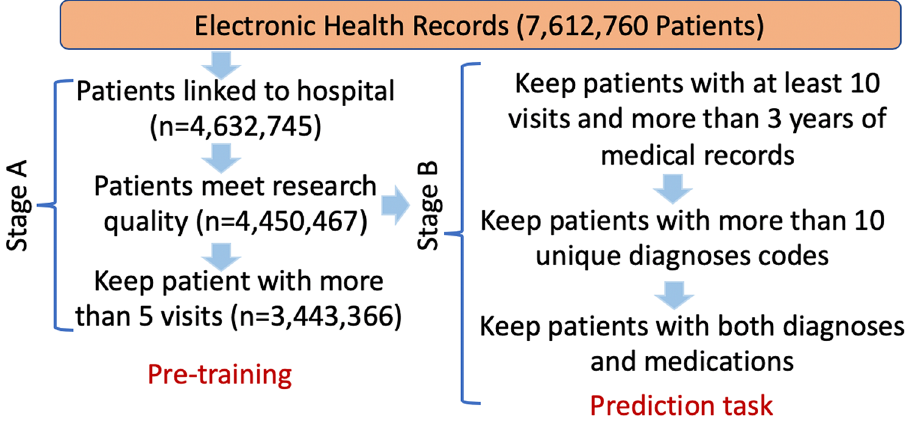
Figure 2. Cohort selection. Stage A illustrates the data cleaning pipeline from the raw CPRD dataset to the dataset for model pre-training, and research quality is an indicator provided by data provider. Stage B is used for patient selection for the incidence prediction tasks. The number of patients kept in each step is represented as n.